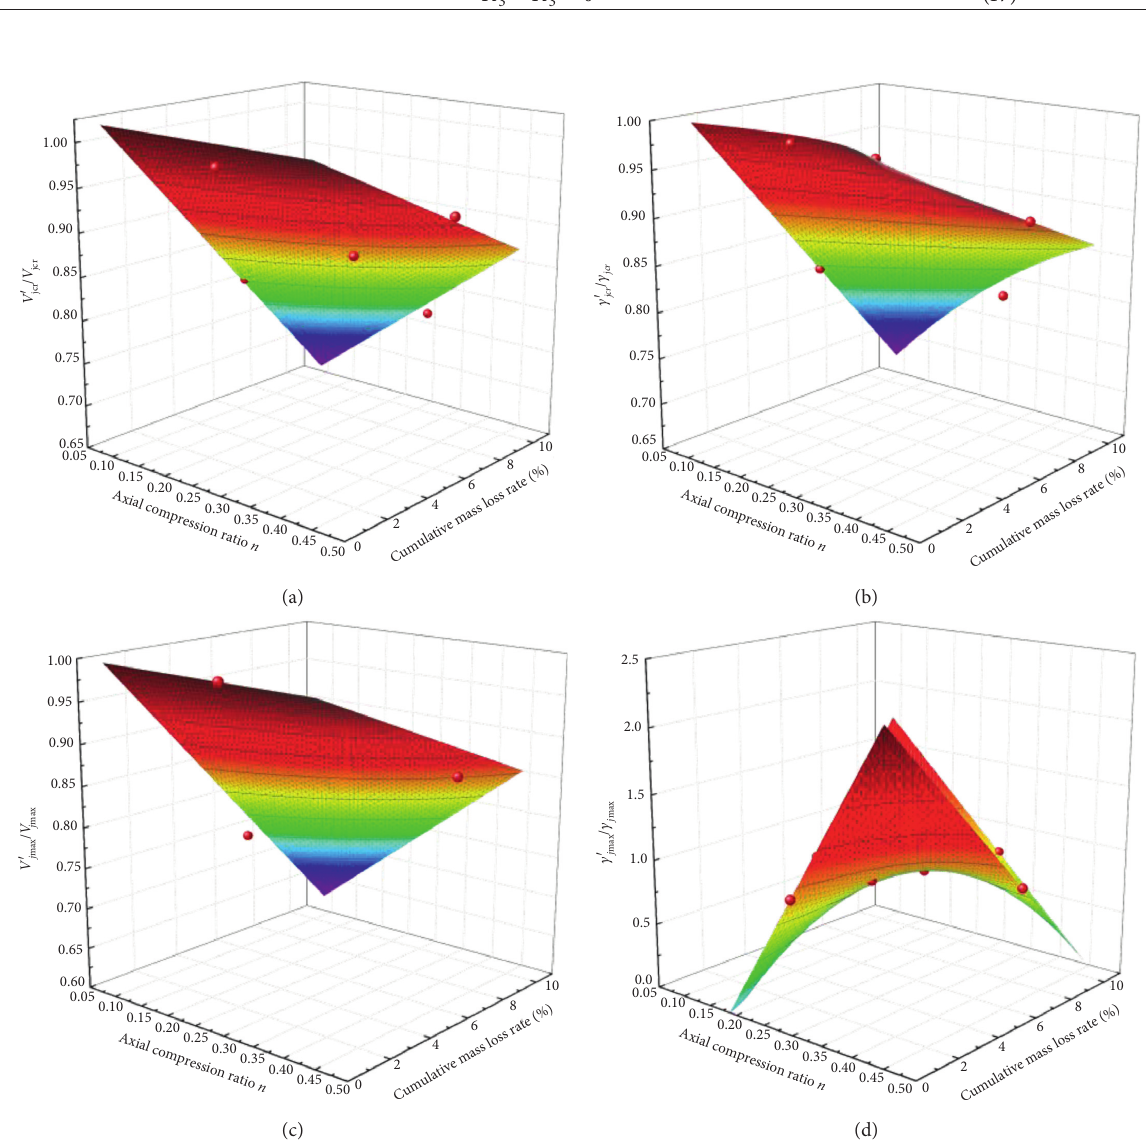
Figure 11: Fitting plots of the characteristic points formulas: (a) Fitting plot of equation (11). (b) Fitting plot of equation (12). (c) Fitting plot of equation (13). (d) Fitting plot of equation